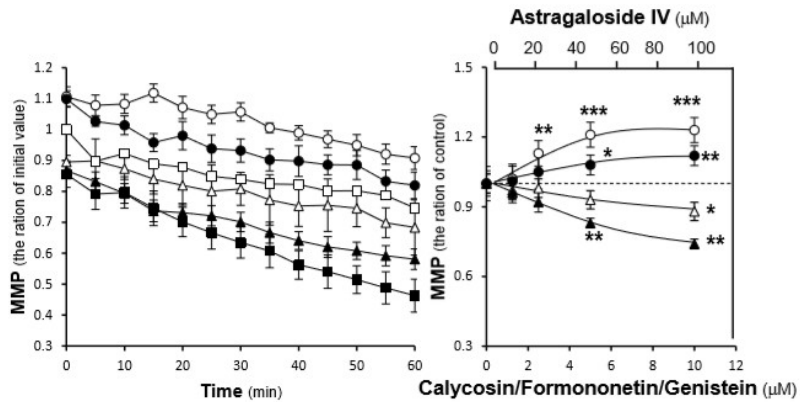
Figure 4. AR compounds regulate the mitochondrial membrane potential of H9C2 cells. Pretreated in 96-well black multi-well plates with a clear bottom for 24 h, H9C2 cells were stained with JC-1 and then washed with PBS-A twice. After adding the indicated concentration of compounds in the wells, the fluorescence of JC-1 aggregates in each sample was measured every 5 min for 60 min at 37 °C. Here, carbonyl cyanide-p trifluoromethoxyphenylhydrazone (FCCP, 100 μM) was used as the positive control. Time course of markers-induced changes in the mitochondrial membrane potential in H9C2 cells ( left panel ). The data are expressed as the ratio of fluorescence intensity of JC-1 aggregates to the respective initial (i.e., 0 min) value. The values given are mean ± SD, with n = 3. The dose-dependent effects of the chosen markers on the mitochondrial membrane potential were recorded ( right panel ). The data are expressed as the ratio of fluorescence intensity of JC-1 aggregates to the corresponding value of the control at 60 min. The values given are mean ± SD, with n = 3. Statistical comparison was made with the control, * p < 0.05, ** p < 0.01, *** p < 0.001.